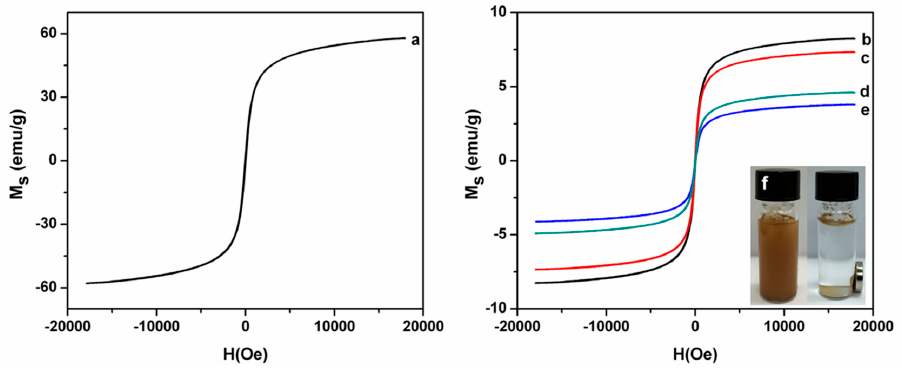
Figure 6. Magnetic hysteresis loops of the Fe 3 O 4 particle ( a ), Fe 3 O 4 -MAH- β -CD@MIP ( b ), Fe 3 O 4 -MAH- β -CD@NIP ( c ), Fe 3 O 4 -CTs@MIP, ( d ) and Fe 3 O 4 -CTs@NIP ( e ). The weight percentages of Fe 3 O 4 that adhered to Fe 3 O 4 -CTs@MIP, Fe 3 O 4